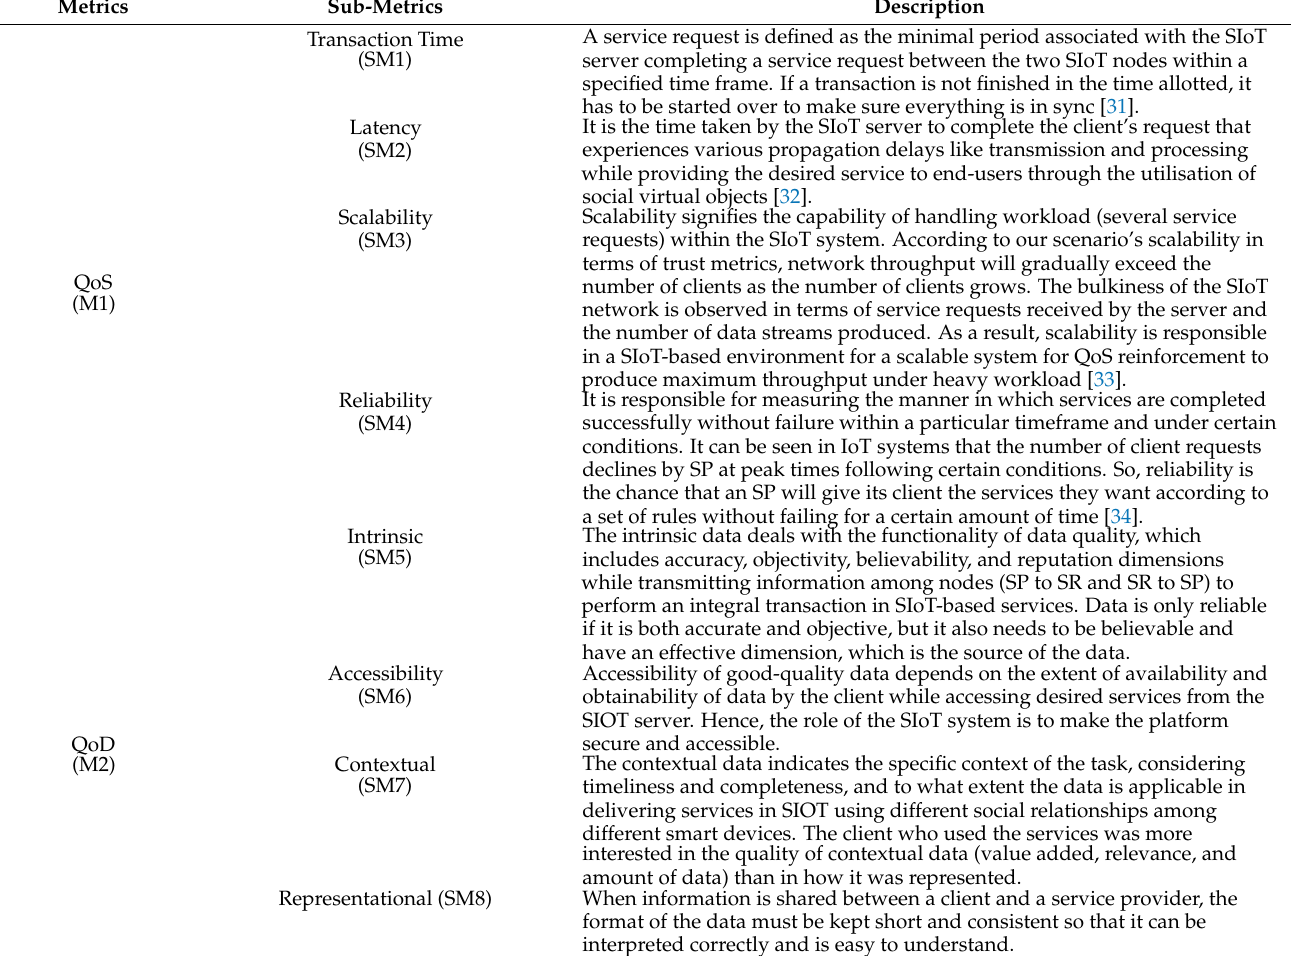
Table 2. List of Sub-trust metrics for Truthful friend